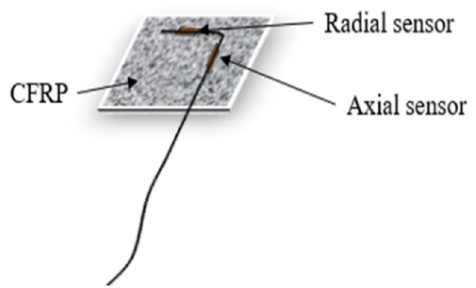
Figure 3. FBGs packaged for axial and lateral strain measurement.